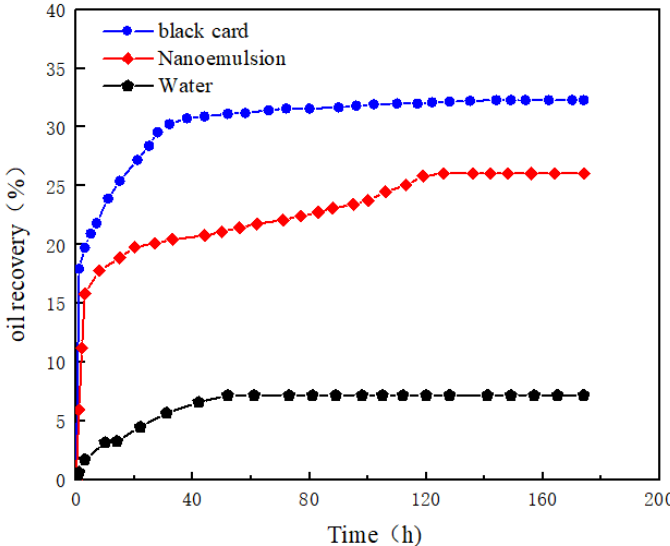
Figure 8. The relationship between the recovery degree of different imbibed fluids and imbibition time.